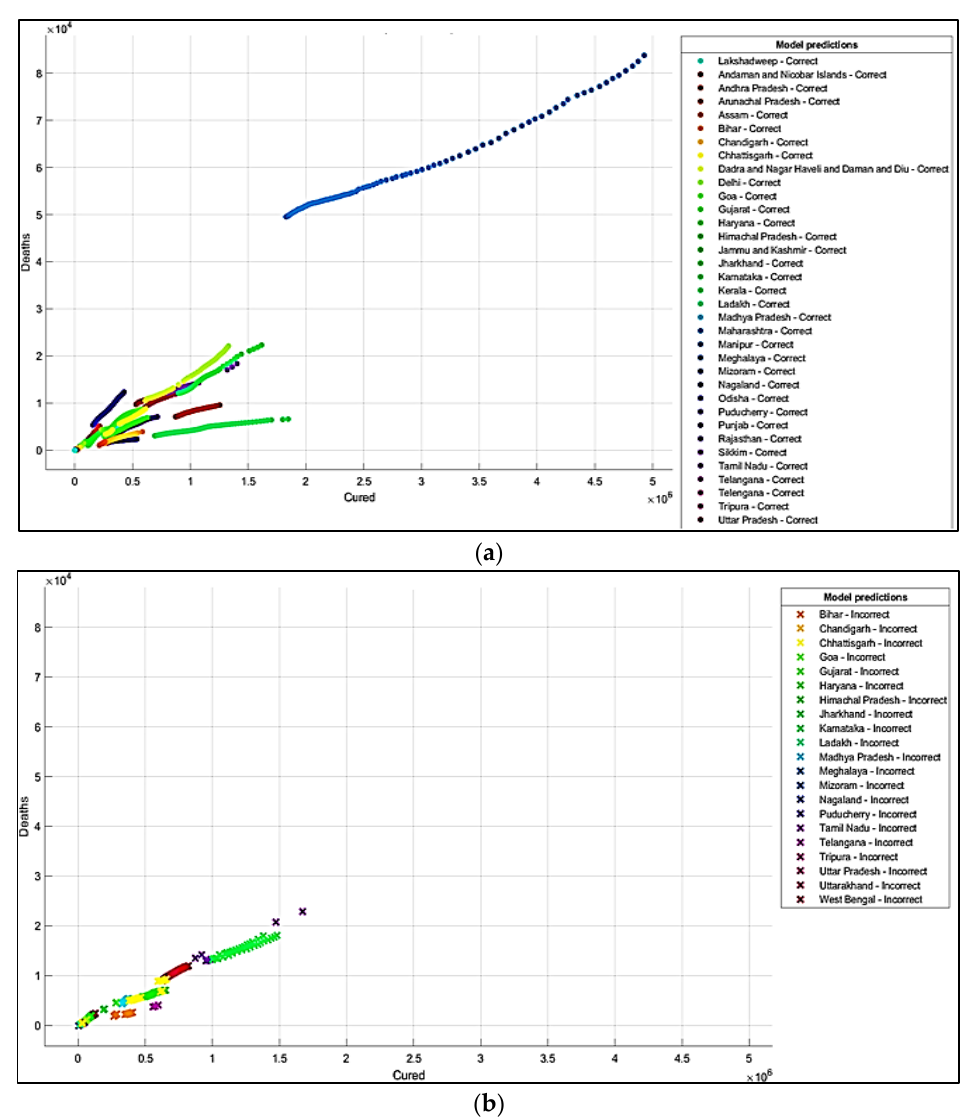
Figure 5. ( a ) Correct Predictions by Gaussian Naïve Bayes ‘Cured’ vs. ‘Deaths’. ( b ) Incorrect Predic- tions by Gaussian Naïve Bayes ‘Cured’ vs. ‘Deaths’.